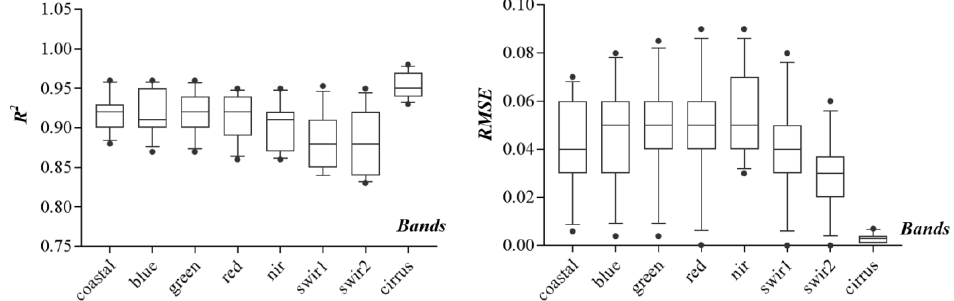
Figure 9. Box plots of average coefficient of determination (R 2 ) and the root mean square error (RMSE) for measuring the consistency of 30-m Landsat-8 TOA reflectance and the corresponding 300-m resampled Landsat-8 TOA reflectance. Horizontal lines in each box plot represent the location of